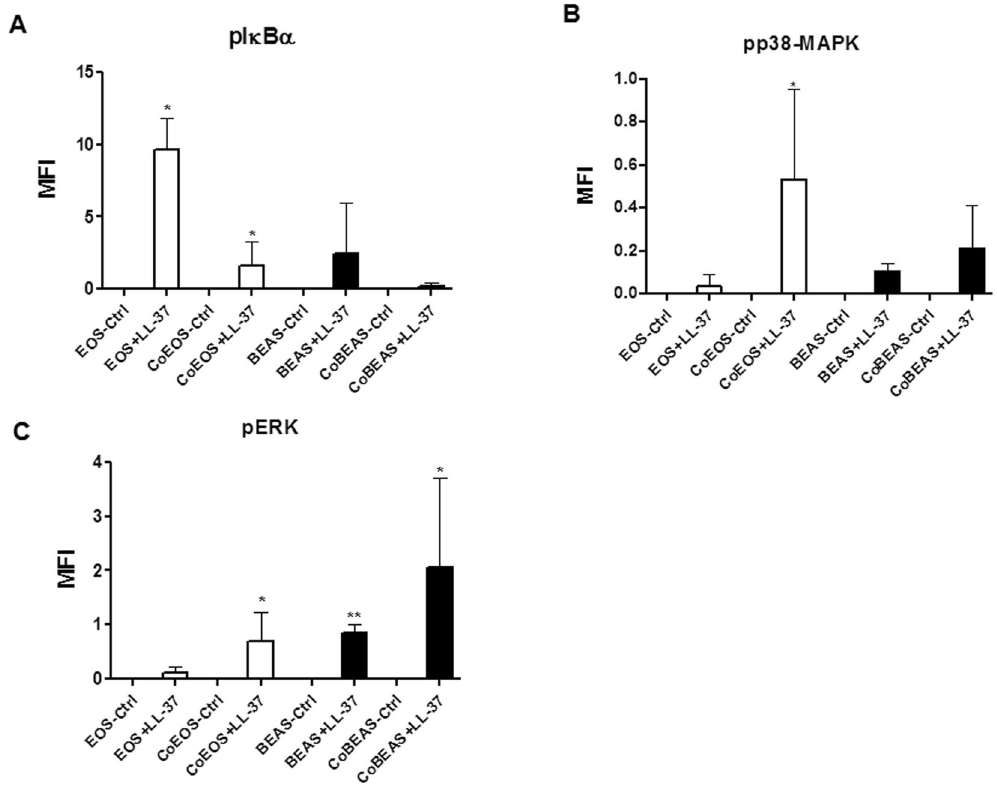
Figure 7. Activation of I κ B α , p38-MAPK and ERK in human eosinophils co-cultured with BEAS-2B cells under LL-37 stimulation. Human eosinophils (1.2 × 10 6 ) and BEAS-2B cells (4 × 10 5 ) were cultured either together or separately with or without 10 µ g/ml LL-37 for 10 minutes prior to fixation and permeabilization. Intracellular levels of phosphorylated I κ B α ( A ), phosphorylated p38 MAPK ( B ), and phosphorylated ERK ( C ) in cells were measured by intracellular staining with specific antibodies and analyzed using flow cytometry. EOS, eosinophils; CoEOS, eosinophils in co-culture; BEAS, BEAS-2B cells; CoBEAS, BEAS-2B cells in co- culture. Results are expressed as MFI subtracting corresponding control groups and shown as arithmetic mean plus SD of triplicate independent experiments. * P < 0.05, ** P < 0.01 when compared between the denoted groups and eosinophil or BEAS-2B cell control